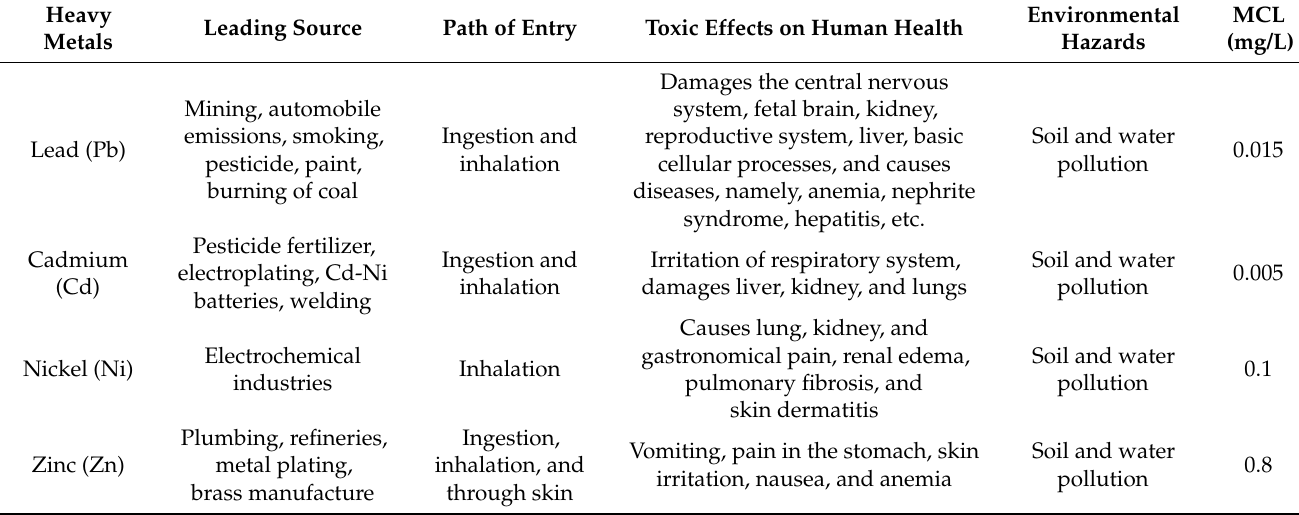
Table 1. Toxic effects of different heavy metals on human health [10,11].